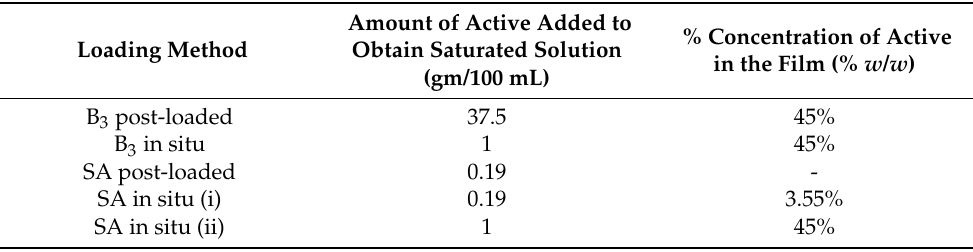
Table 1. Summary of the exact amount of model active added in the solution and active concentration inside the film in both methods of